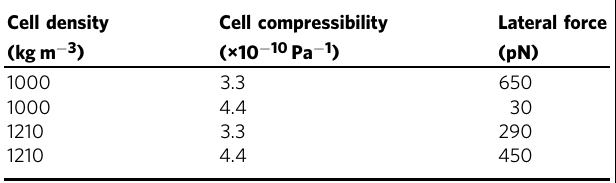
Table 1 Lateral trapping force as a function of cells ’ compressibility and